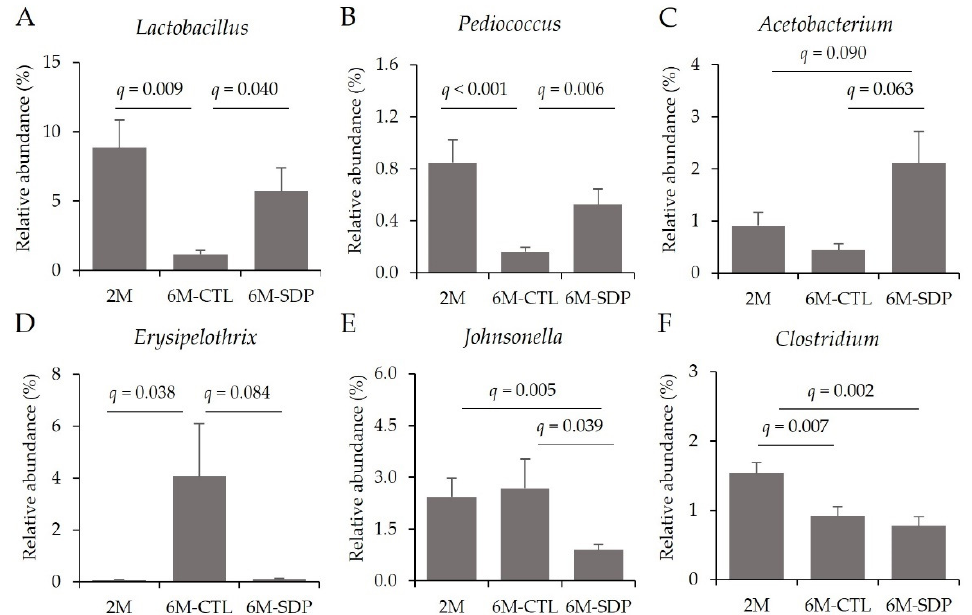
Figure 9. Fecal microbial composition at the genus level of the Firmicutes phylum. Relative abun- dance of Lactobacillus ( A ), Pediococcus ( B ), Acetobacterium ( C ), Erysipelothrix ( D ), Johnsonella ( E ), and Clostridium ( F ). Results are expressed as mean ± SEM ( n = 10–11 mice/group). Statistics: ANOVA (False discovery rate, Benjamini and Hochberg multiple comparison test).